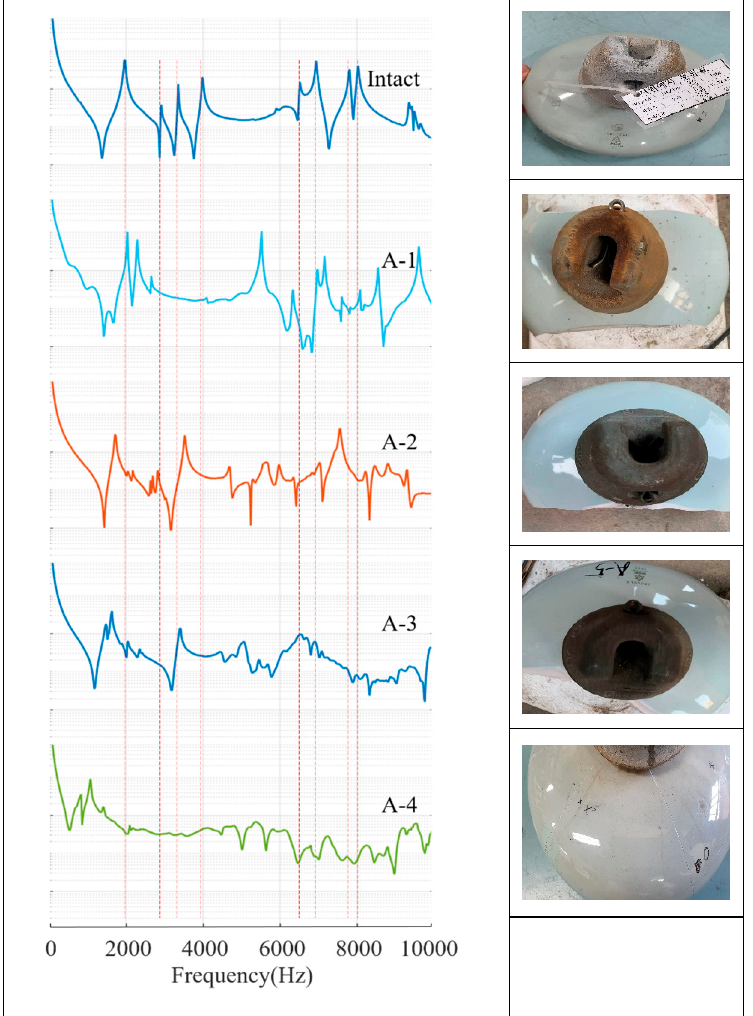
Figure 6. Defective porcelain samples and FRF result. A-1, A-2, A-3: Broken porcelain discs; A-4: Porcelain disc with crack.